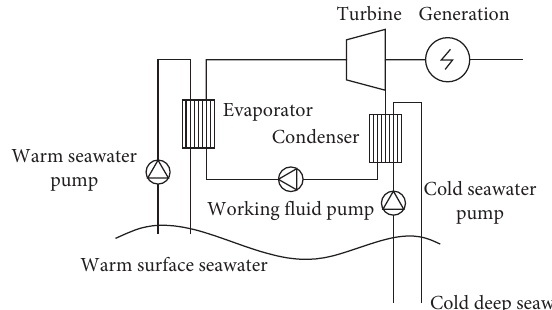
Figure 1: Diagram of OTEC ORC with zeotropic working fuid.